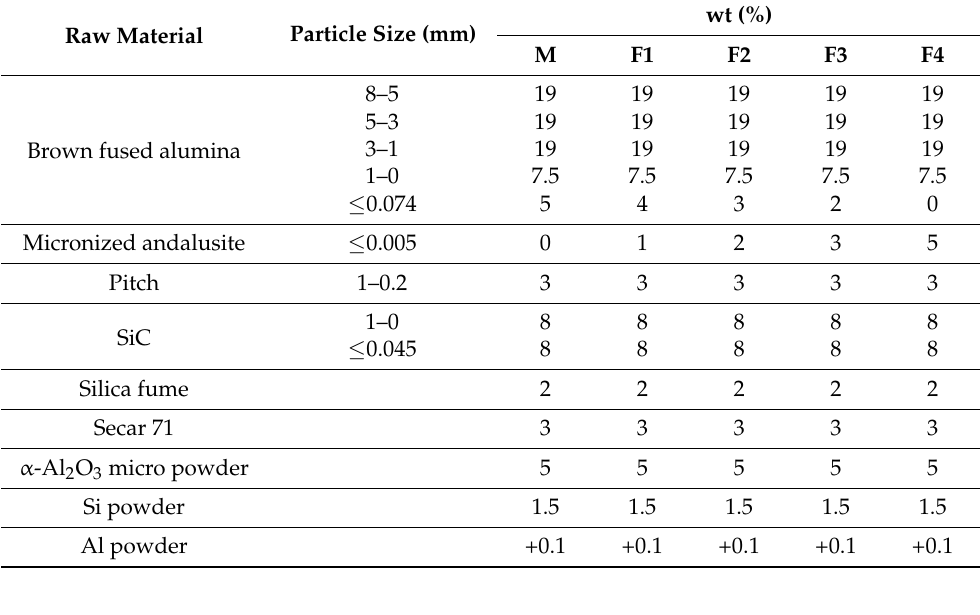
Table 1. Mass fractions (wt%) and particle sizes (mm) of raw materials in Al 2 O 3 -SiC-C (ASC) castables.